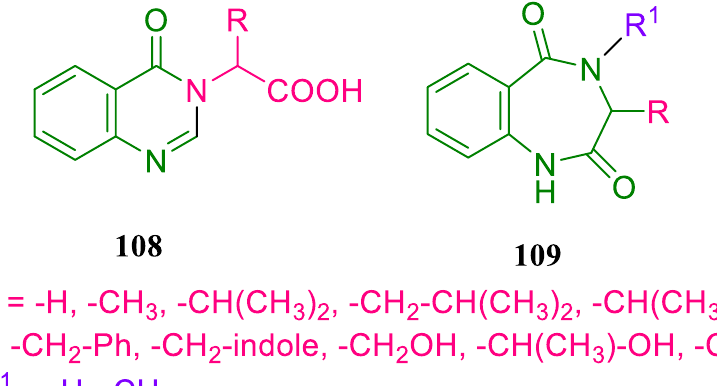
Figure 88. Quinazolinones and 1,4-benzodiazepine-2,5-diones conjugated to amino acids. Rakesh K P et al. synthesised a novel series of amino acid-conjugated quinazoline- Schiff bases ( 110 ) to treat fungal and bacterial diseases (Figure 89). The synthesised quinazolinone-Schiff’s base conjugates were evaluated for their in vitro antimicrobial ac- tivity against various bacterial and fungal strains by using streptomycin and bavistin as reference standards. The bacterial strains comprises both Gram-positive ( S. aureus ) and Gram-negative ( E. coli ), while the fungal strains include F. oxysporum and A. niger . The